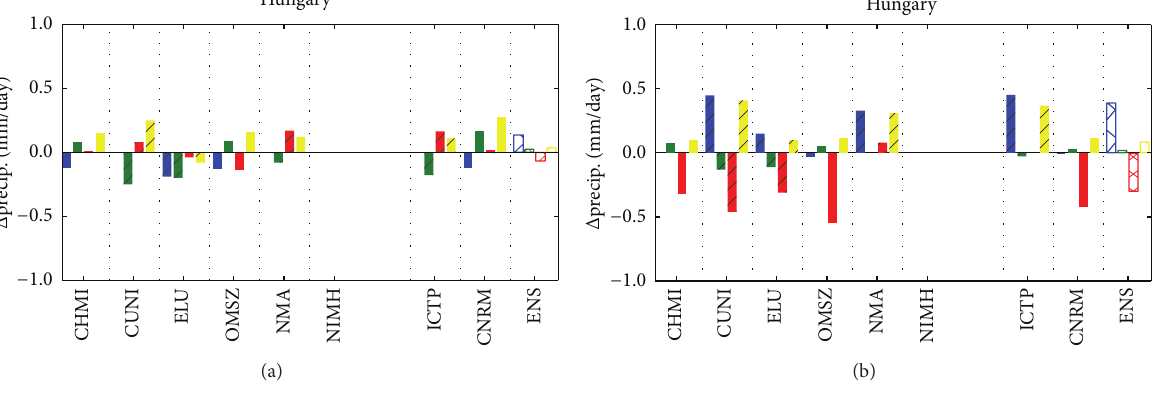
Figure 12: As Figure 10 for Hungary.